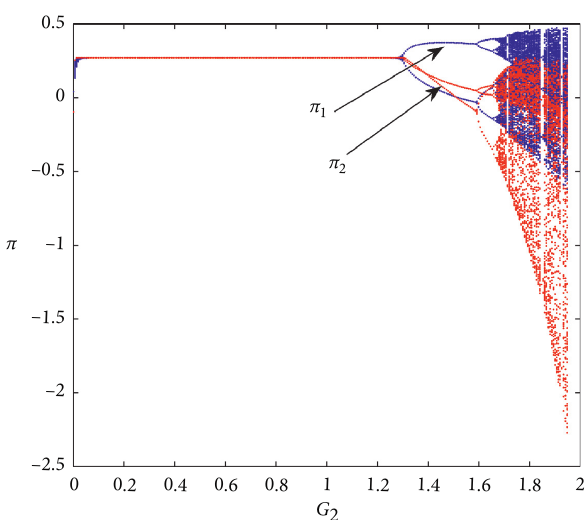
Figure 5. The parameter settings are as follows: v